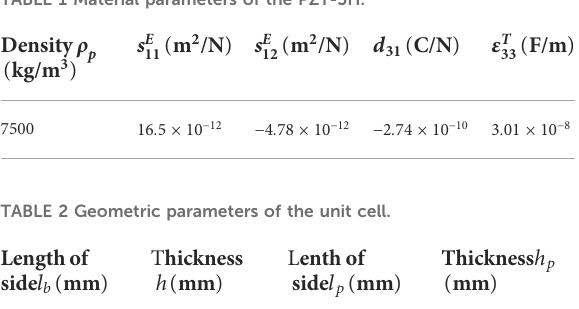
TABLE 1 Material parameters of the PZT-5H.